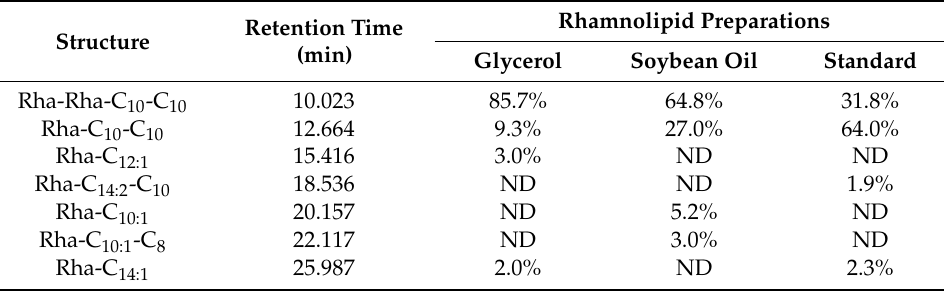
Table 2. The components of rhamnolipid